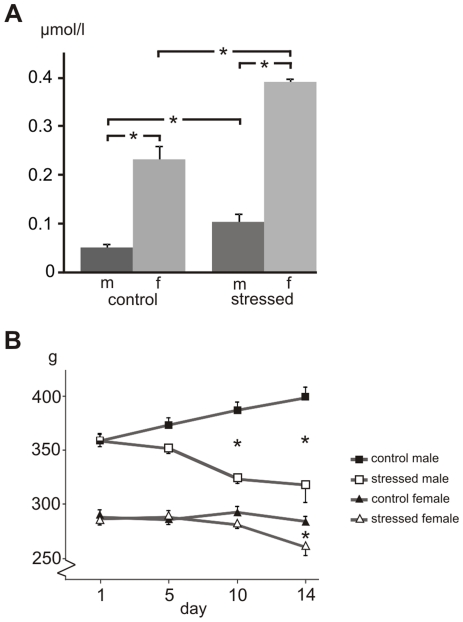
Corticosterone titer and body weight after stress.Corticosterone titer in µmol/l (A) and body weight in grams (B) of control and stressed male (m) and female (f) rats. Means and SEM, n  =  6 per group, * statistical difference between groups indicated, at P < 0.05.